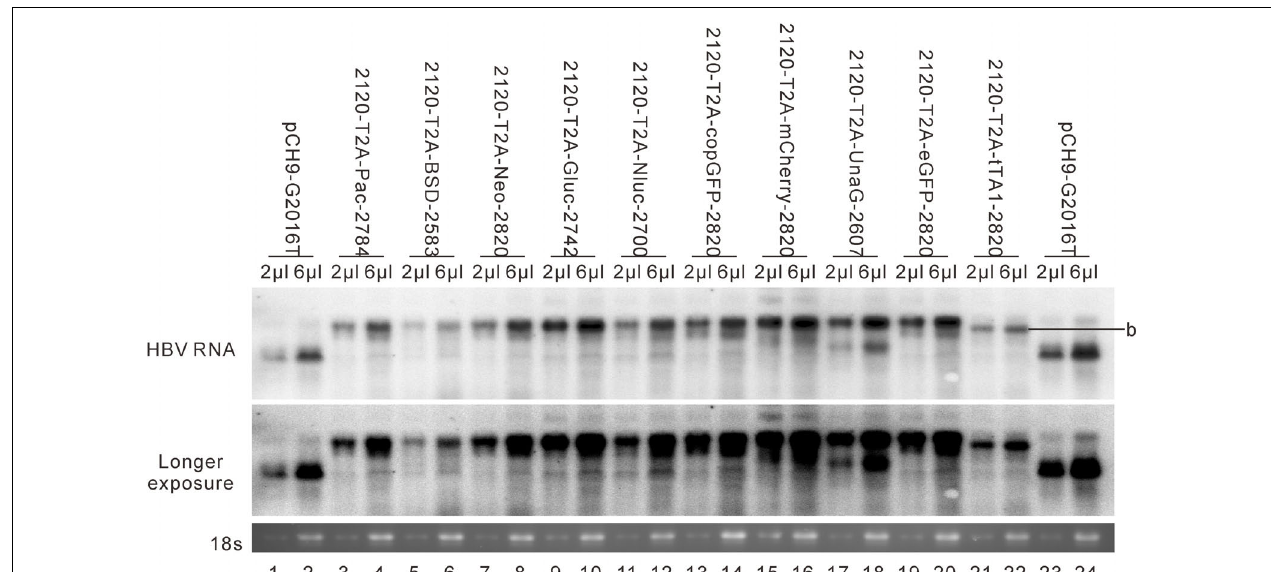
FIGURE 6 | RNA assay for the 2120 recombinants. Representative Northern blotting is